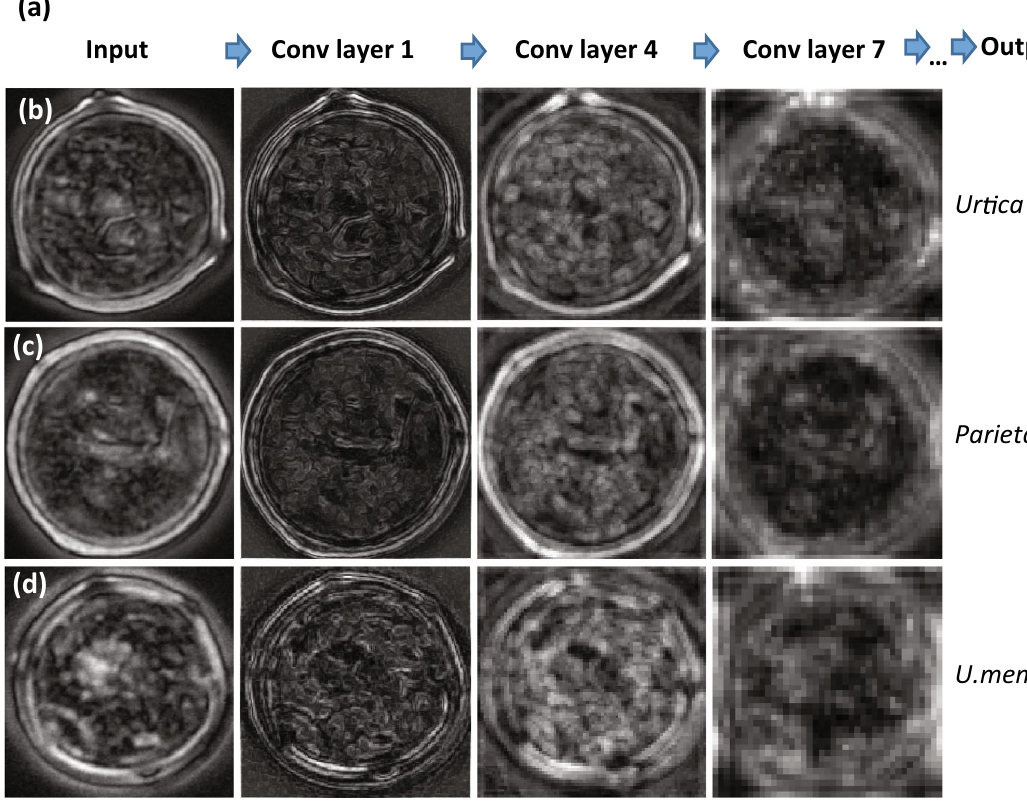
Figure 2. Feature maps. (a) simplified view of the VGG16 model showing three convolutional layers. ( b – d ) Feature maps of Urticaceae pollen grains from the standard deviation projection created using ImageJ, that were confidently distinguished by the CNNs. ( b ) Urtica urens , ( c ) Parietaria judaica and ( d ) Urtica membranacea . Activation levels are indicated with white indicating high activation and black very low/no activation.